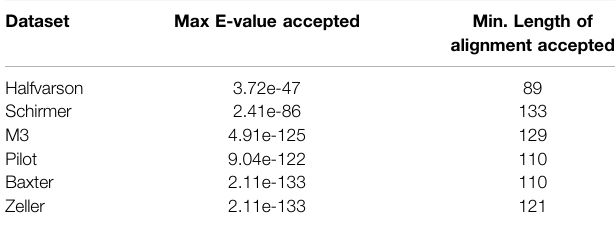
TABLE 1 | Maximum E-value and minimum length of alignment that were accepted in aligning sequences from each dataset to embedding transformation sequences.